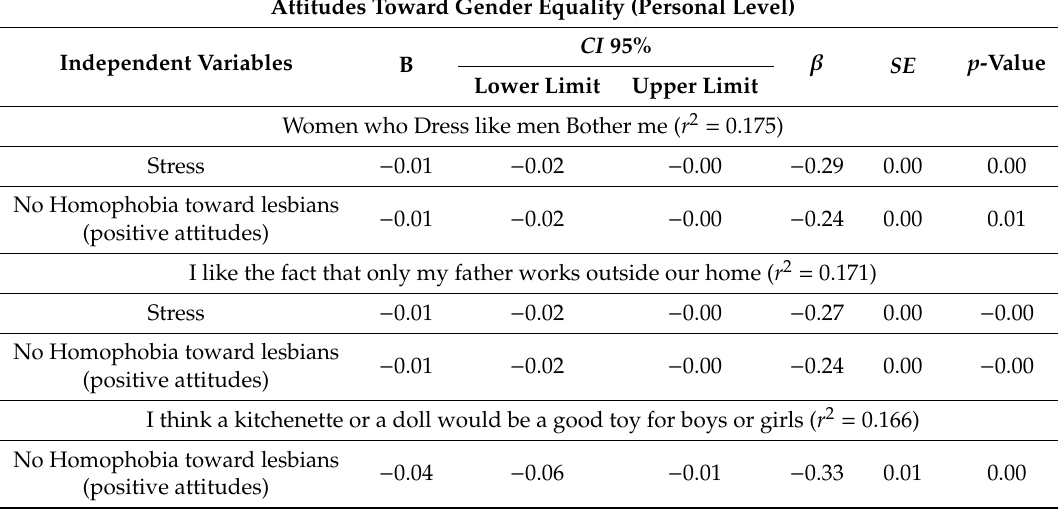
Table 7. Regression of “attitudes toward gender equality” (significant items at personal level) for the variables of homophobia toward gays and lesbians, self-esteem, emotional intelligence, empathy, levels of everyday stress, and resilience in university